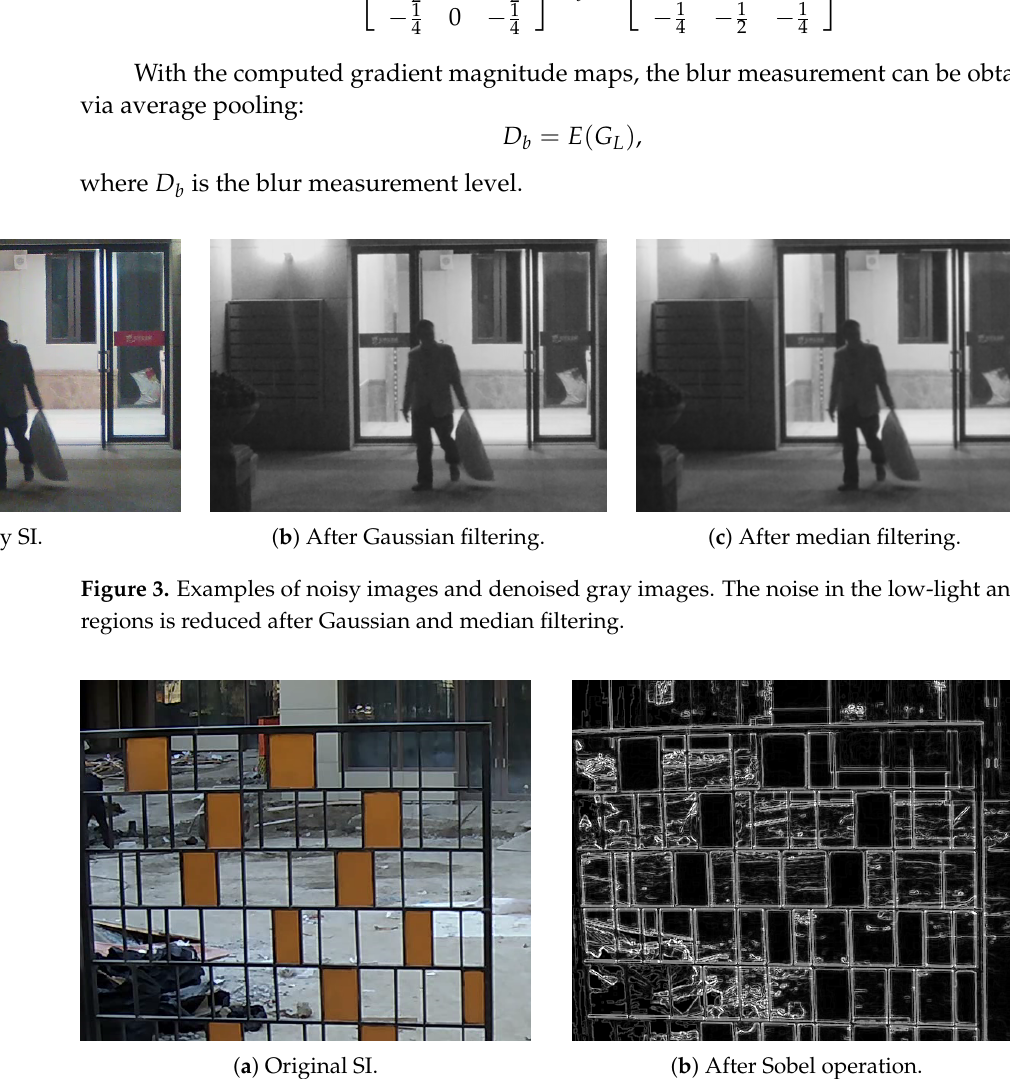
Figure 4. Illustration of an example of original SI and Sobel-operated